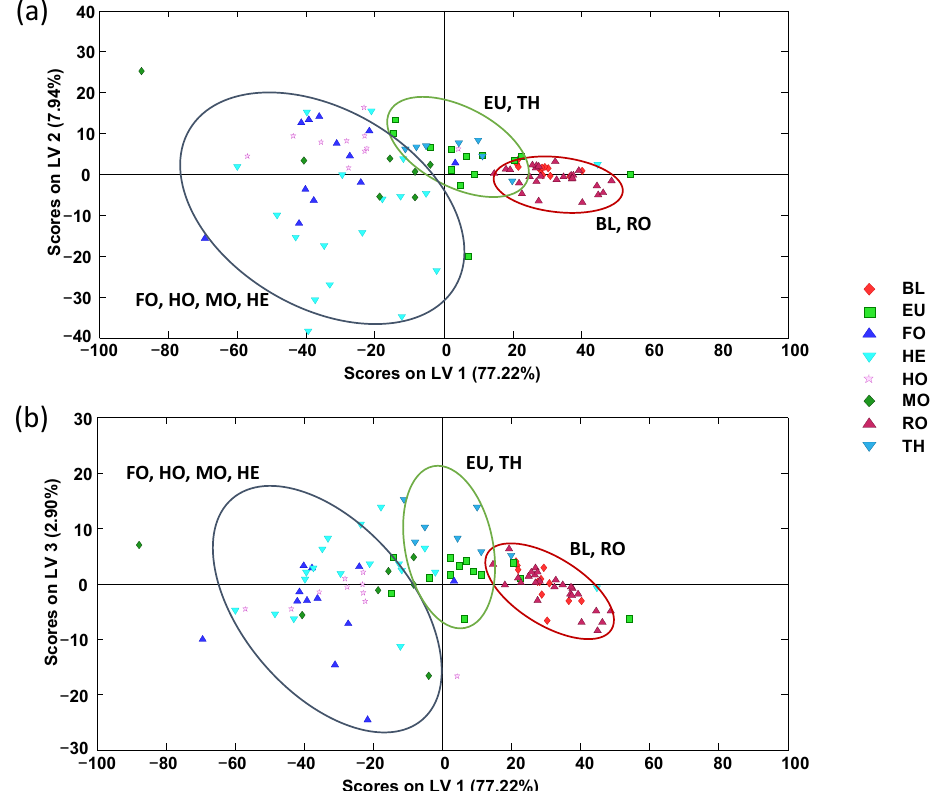
Figure 3. Supervised PLS-DA score plots of ( a ) LV1 vs. LV2 and ( b ) LV1 vs. LV3 when using non-targeted HPLC-UV chromatographic fingerprints (at 280 nm) as honey chemical descriptors for botanical origin classification (3 LVs were used to build the model). QCs and multifloral honeys were not considered. BL: Orange/lemon blossom; EU: Eucalyptus; FO: Forest; HE: Heather; HO: Holm oak; MO: Mountain; RO: Rosemary; TH: Thyme.